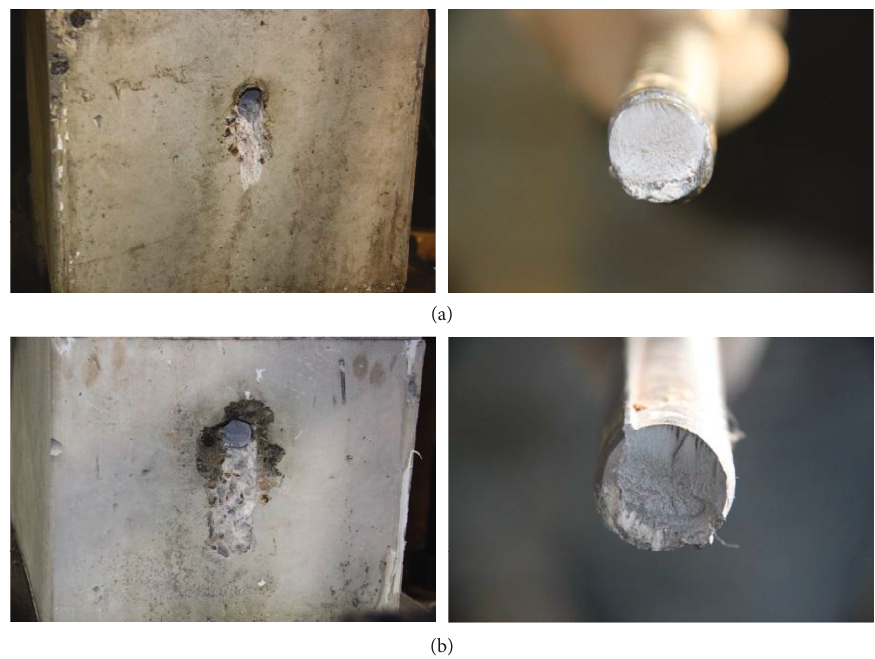
Figure 7: Typical failure mode of specimens (a) D20-F and (b)